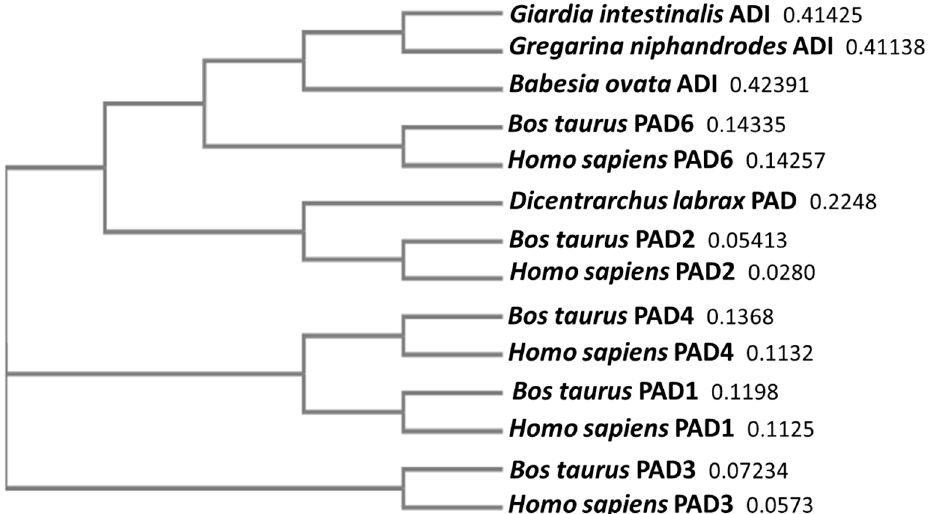
Figure 2. A neighbour-joining phylogeny tree for Alveolata ADI/PAD homologues. Known ADI/PAD protein sequences from two representative alveolates ( Gregarina niphandrodes and Babesia ovate —as protein ADI sequences that have been reported in these species —show closest similarity to the known parasite ADI ( Giardia intestinalis ). The closest homology was then found with mammalian PAD6 and PAD2, followed by teleost PAD ( Dicentrarchus labrax shown as an example). The tree includes all five human ( Homo sapiens ) and bovine ( Bos taurus ) PAD isozymes (PAD1, 2, 3, 4 and 6, respectively) to represent mammalian PADs (the numbers next to the species names represent a measure of support for the node).